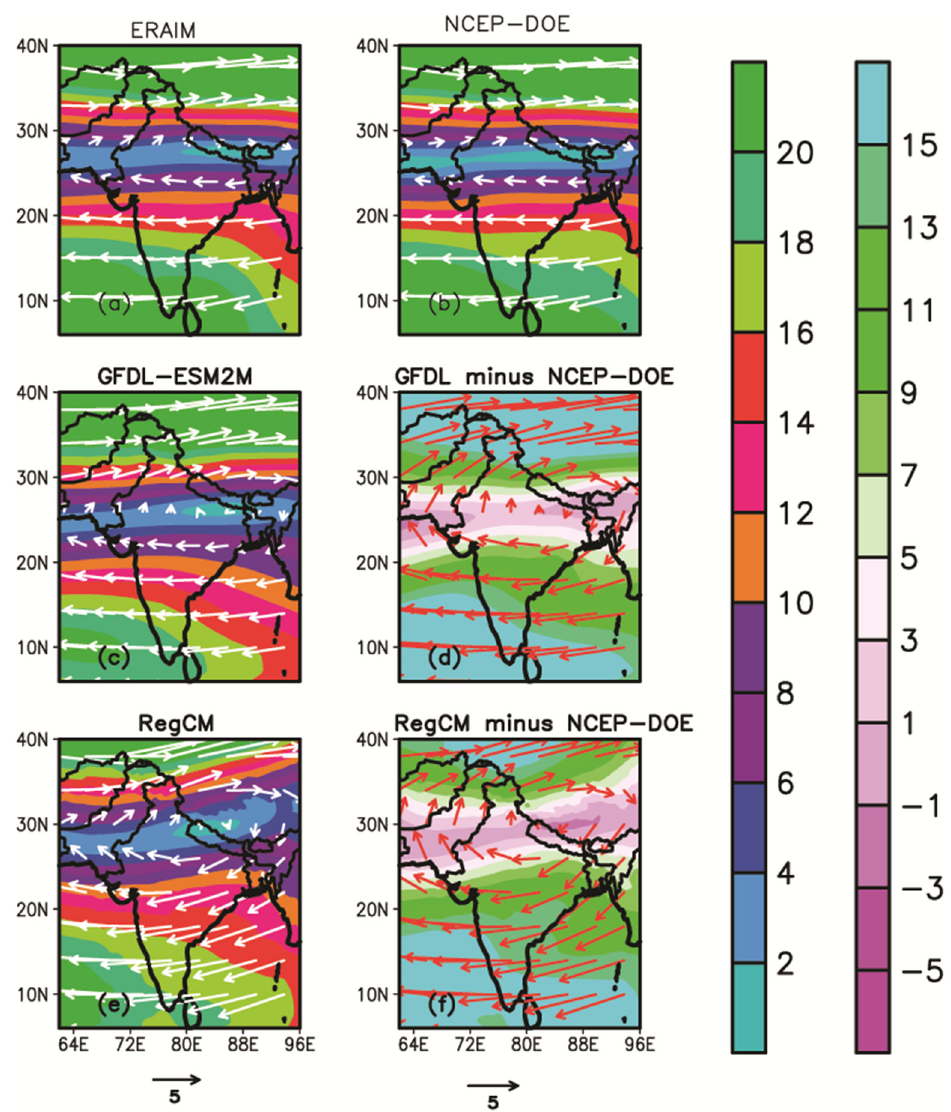
Figure 6. Spatial distribution of SASM mean upper level wind (200 hpa) speed (shading, m/s) and direction (arrows) for ( a , b ) ERA Interim and NCEP observations; ( c , d ) GFDL − ESM2M and its bias with respect to observation; ( e , f ) RegCM4 and its bias with respect to